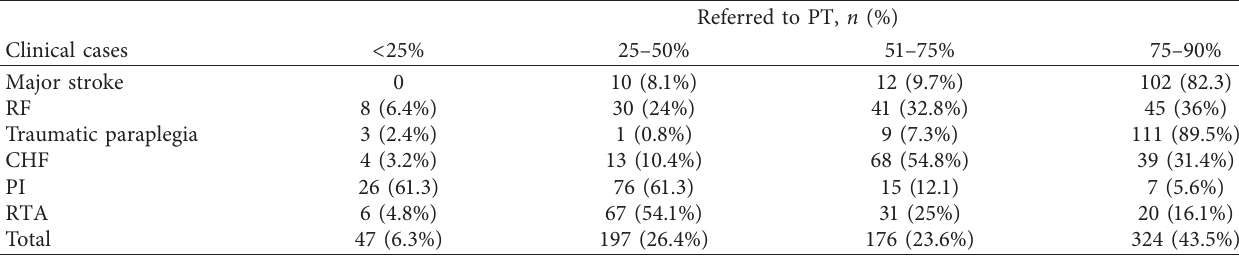
Table 2: Frequency of clinical cases referred to physical